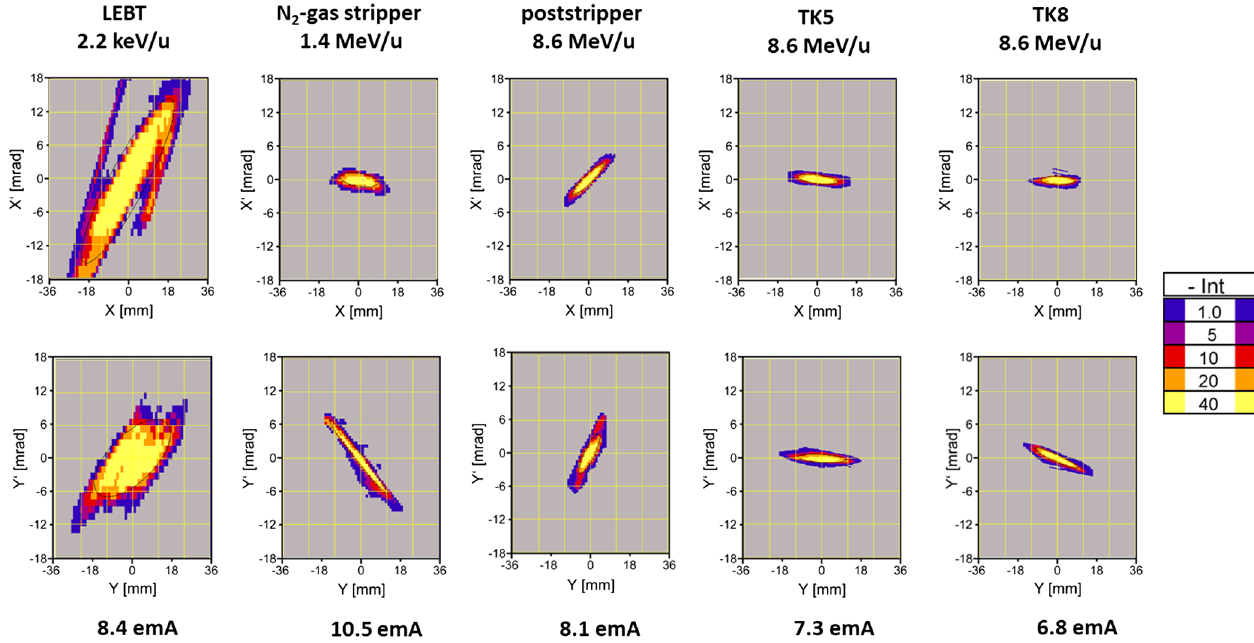
FIG. 10. High-intensity 40 Ar-beam emittance and current measurements along UNILAC and TK.